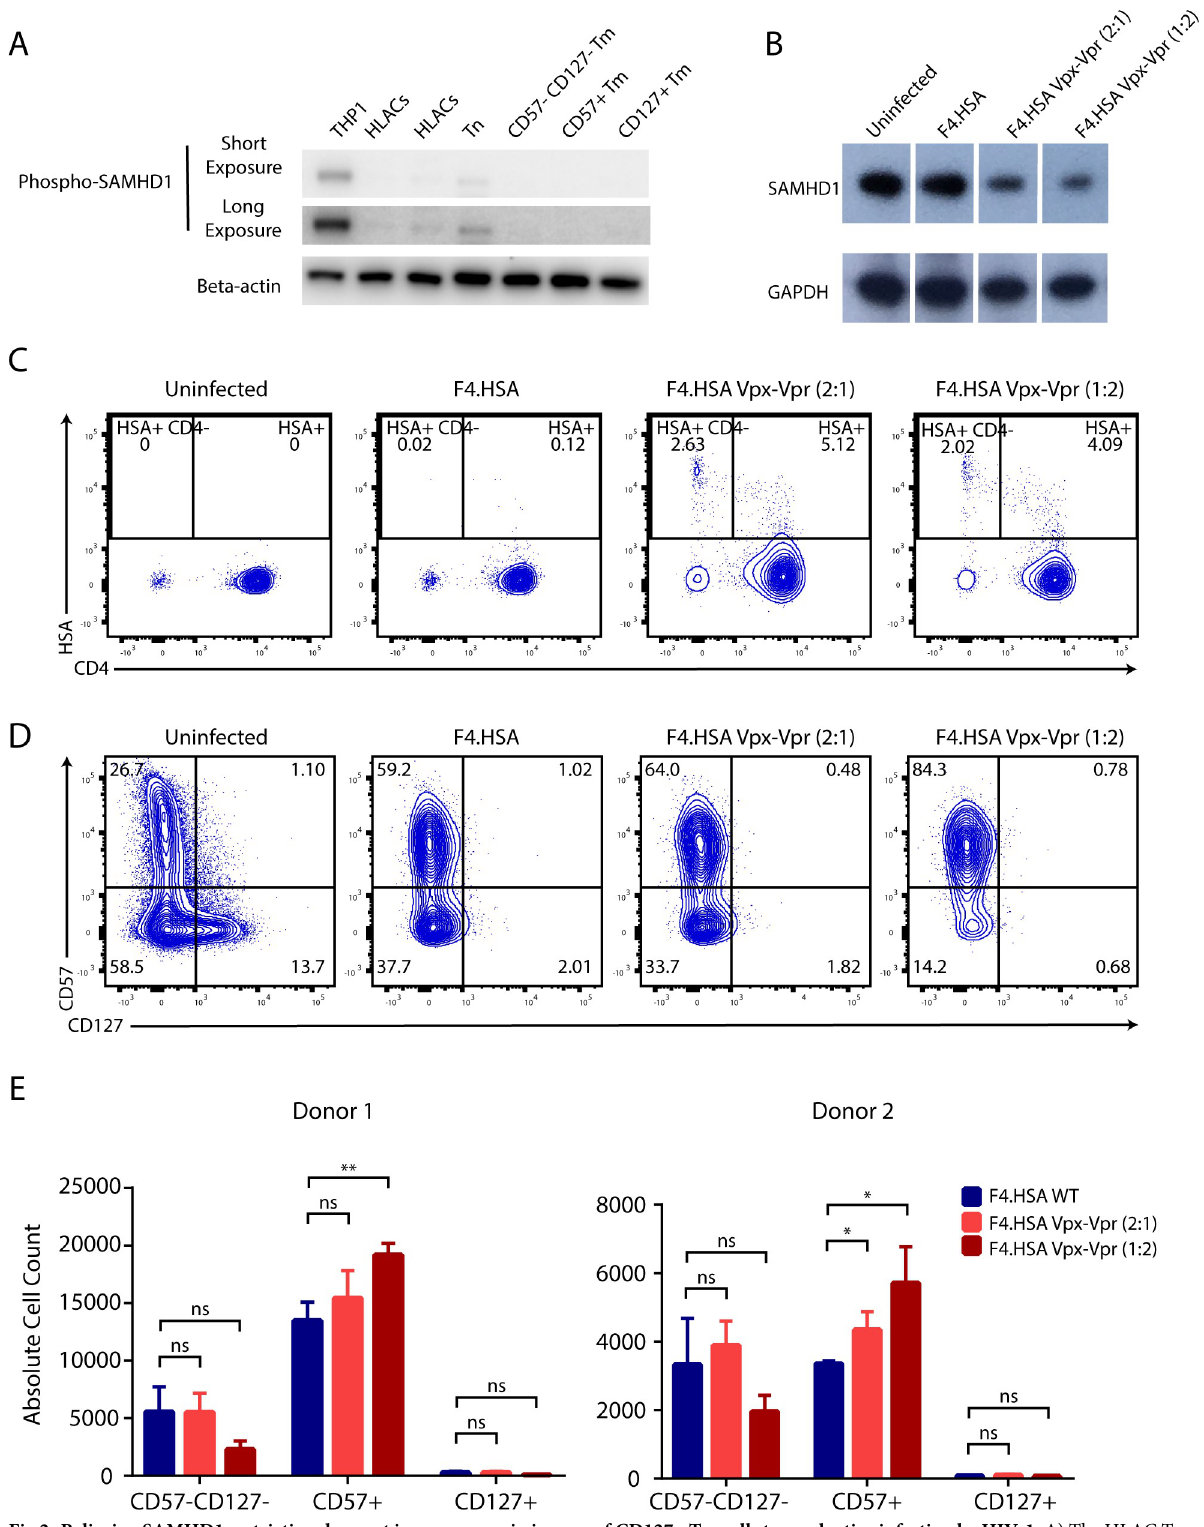
Fig 2. Relieving SAMHD1 restriction does not increase permissiveness of CD127+ Tm cells to productive infection by HIV-1. A) The HLAC Tm subsets express low levels of phospho-SAMHD1. Amounts of SAMHD1 phosphorylated at Thr592 in THP1 cells, total HLACs, Tn cells, and the three Tm subsets, as determined by Western blot. Beta-actin served as a loading control. Both short and long exposures of the phospho-SAMHD1 blots are